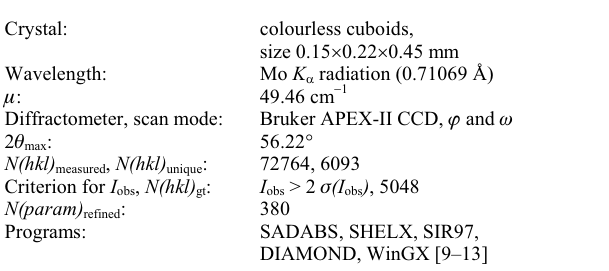
Table 1. Data collection and handling.